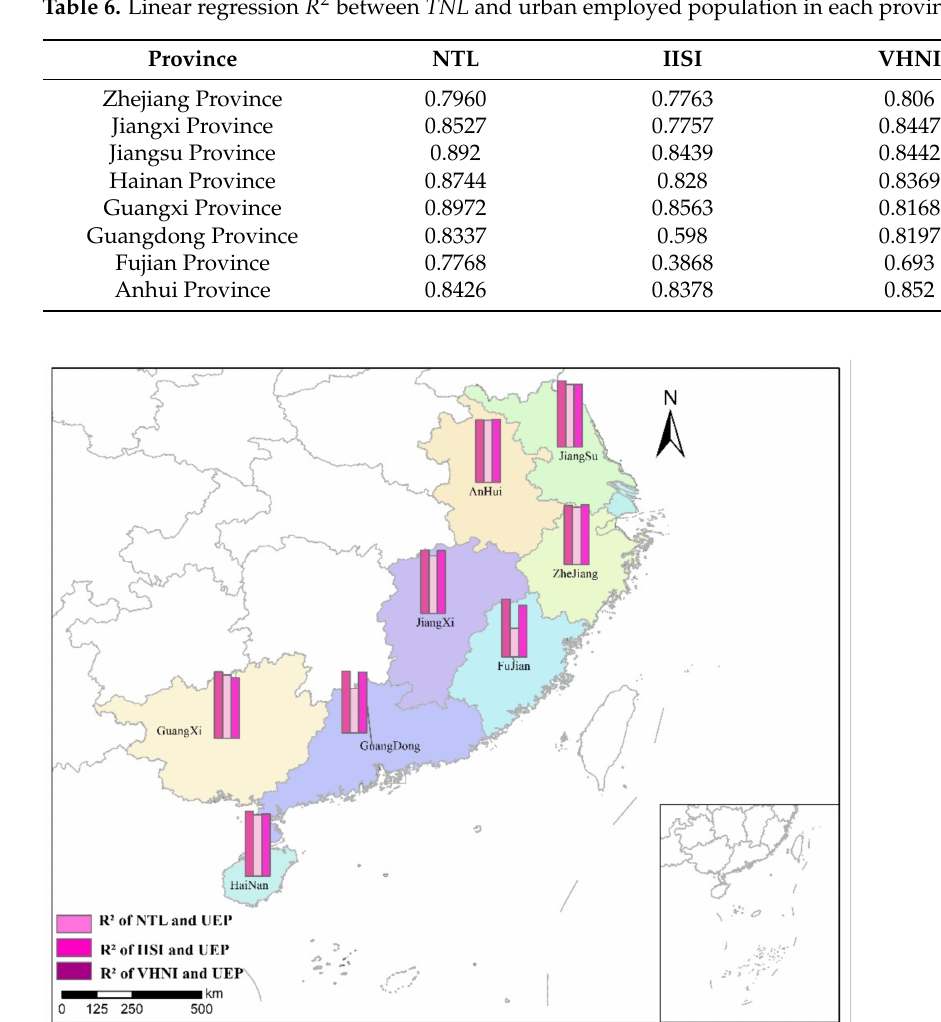
Figure 12. R 2 spatial distribution of TNL and urban employed population linear